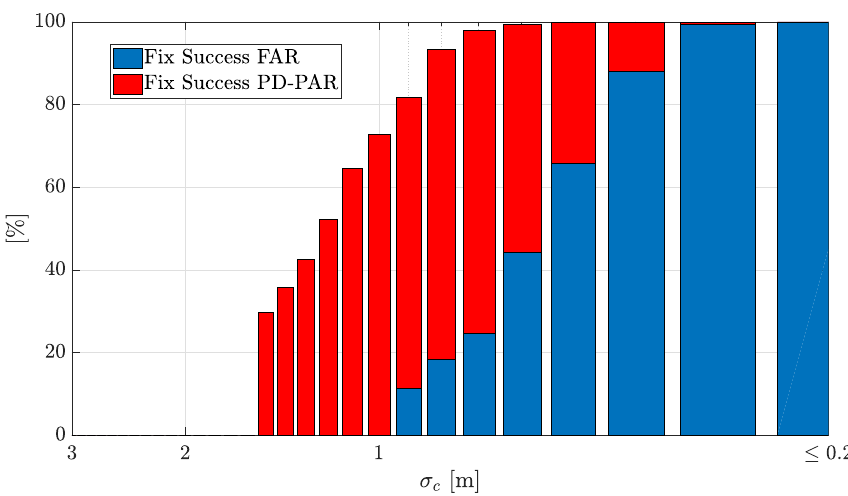
Figure 3. Comparison of the single-epoch IAR experimental success rate for FAR and PD-PAR schemes. At high code-noise levels σ c > 1 [ m ] , an IAR is still achieved with a precision-aided PAR scheme approach.